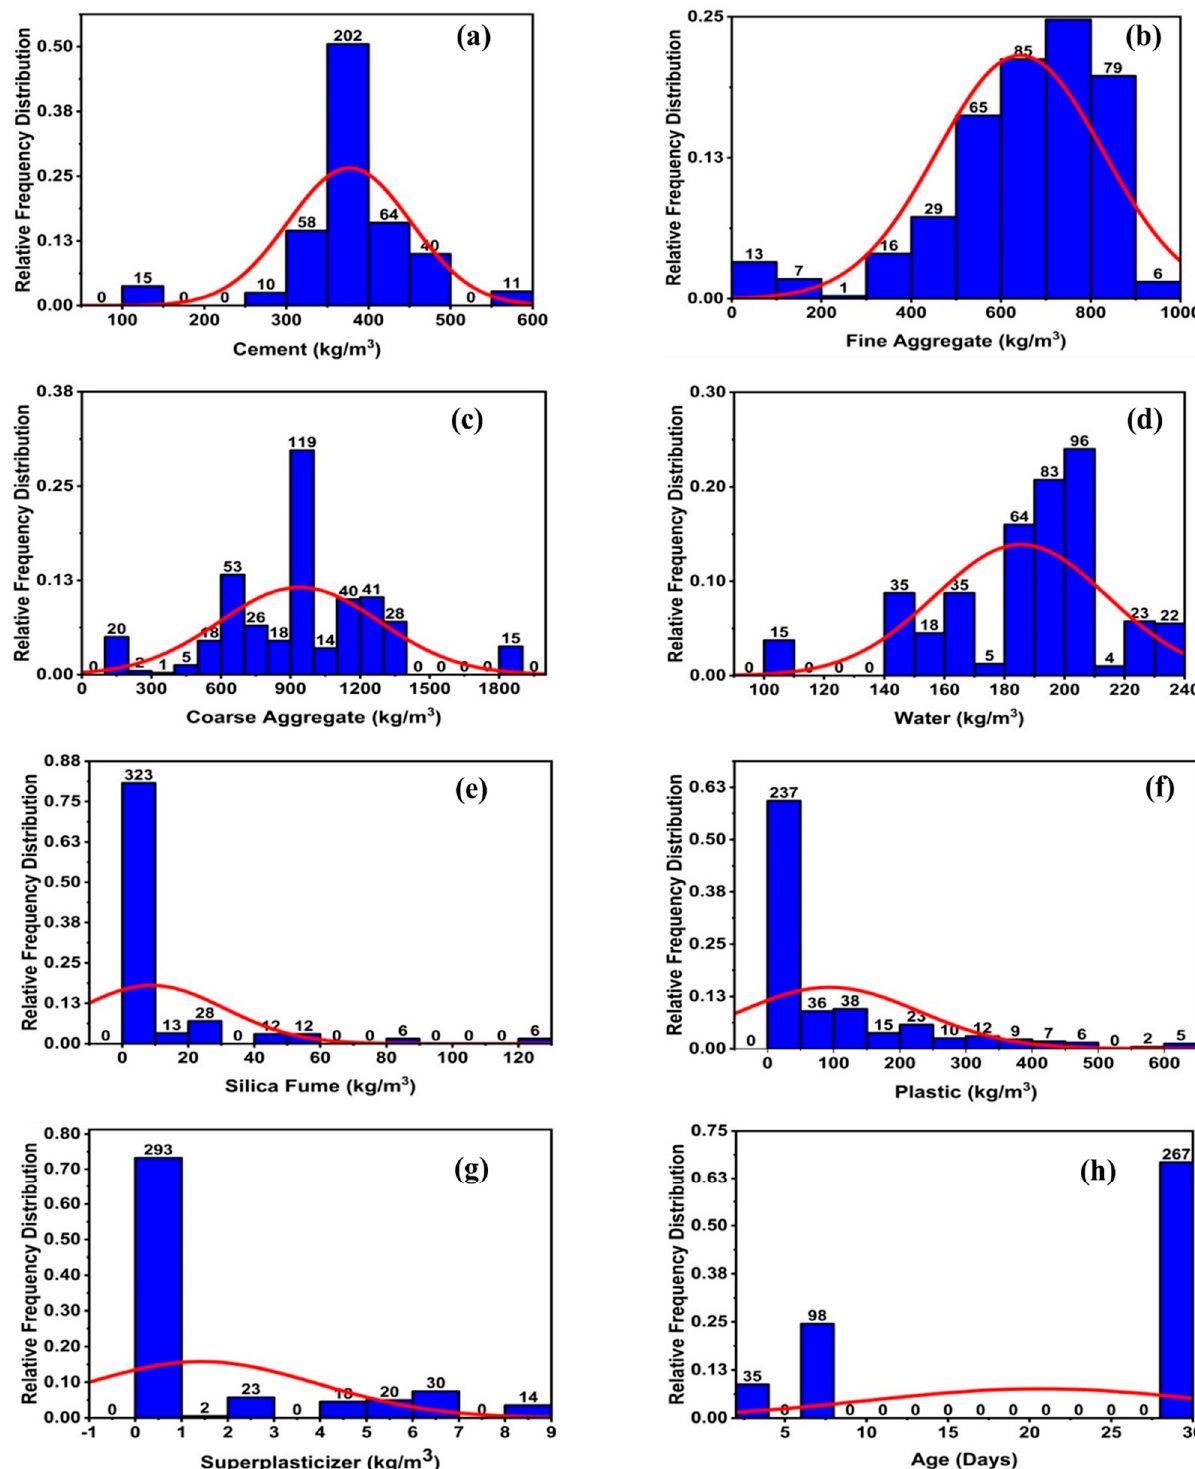
Figure 3. Compressive strength parameters’ relative frequency distribution; ( a ) cement, ( b ) fine aggregate, ( c ) coarse aggregate, ( d ) water, ( e ) silica fume, ( f ) plastic, ( g ) superplasticizer, and ( h ) age .